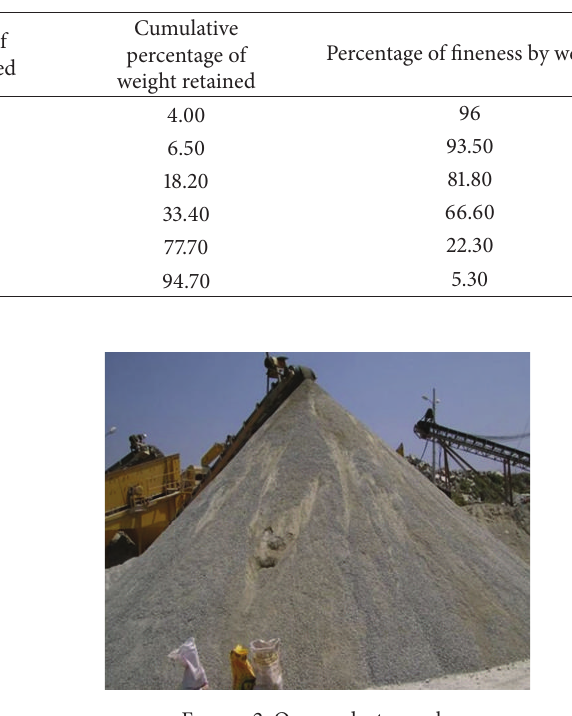
Figure 2: Quarry dust